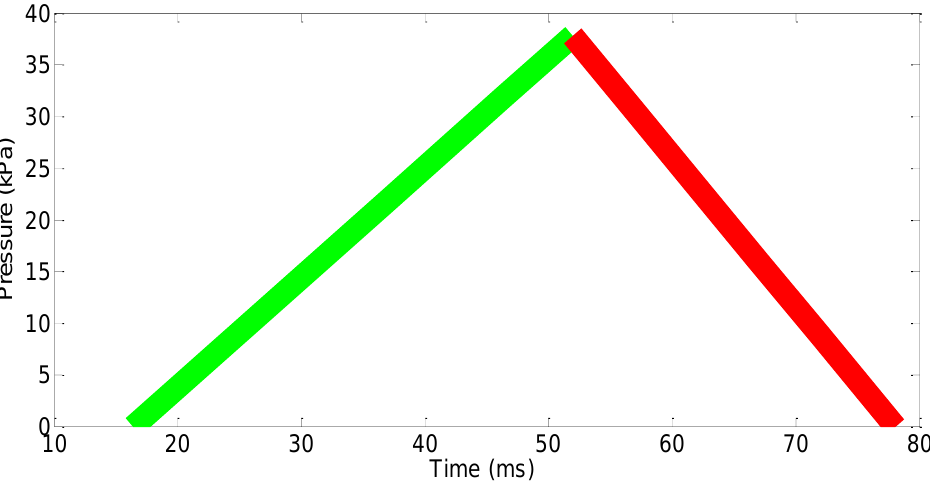
Fig. 7. Pressure time curve for roof